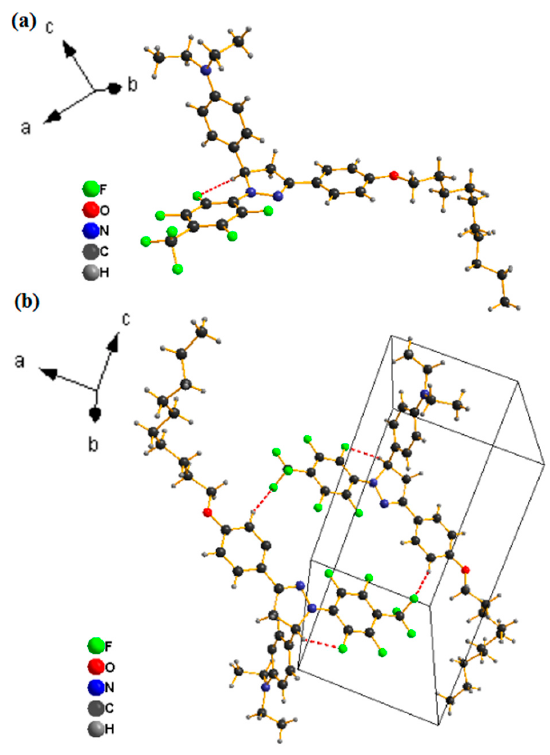
Figure 4. ( a ) Single crystal structure and ( b ) molecular packing diagram of compound PPDPD.